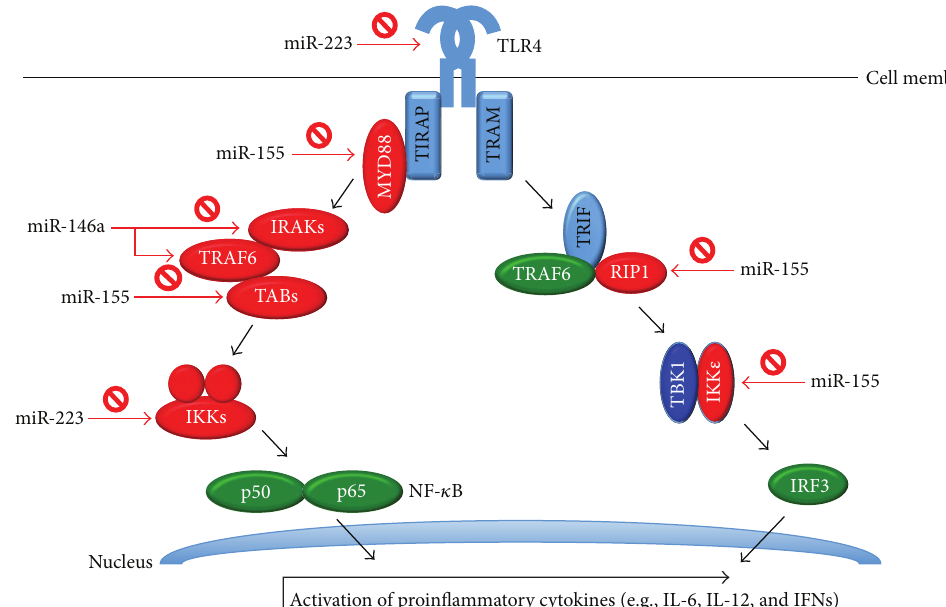
Figure 7: Negative regulation of toll-like receptor signaling by microRNAs. TLR: toll-like receptor; MyD88: myeloid differentiation marker 88; TRAM: TRIF-related adaptor molecule; TIRAP: TIR-associated protein; TRIF: TIR domain-containing adapter inducing; IRAK: IL- 1 receptor-associated kinase; TRAF: TNF receptor-associated factor; TAB: TAK binding protein; IKK: I kappa B kinases; RIP: receptor- interacting protein; TBK: TANK-binding kinase; IRF: interferon regulatory factor; NF- 𝜅 B: nuclear factor kappa B; IL: interleukin; IFN: interferon; miR: microRNA. Potential target molecules regulated by miRNAs are represented in red.